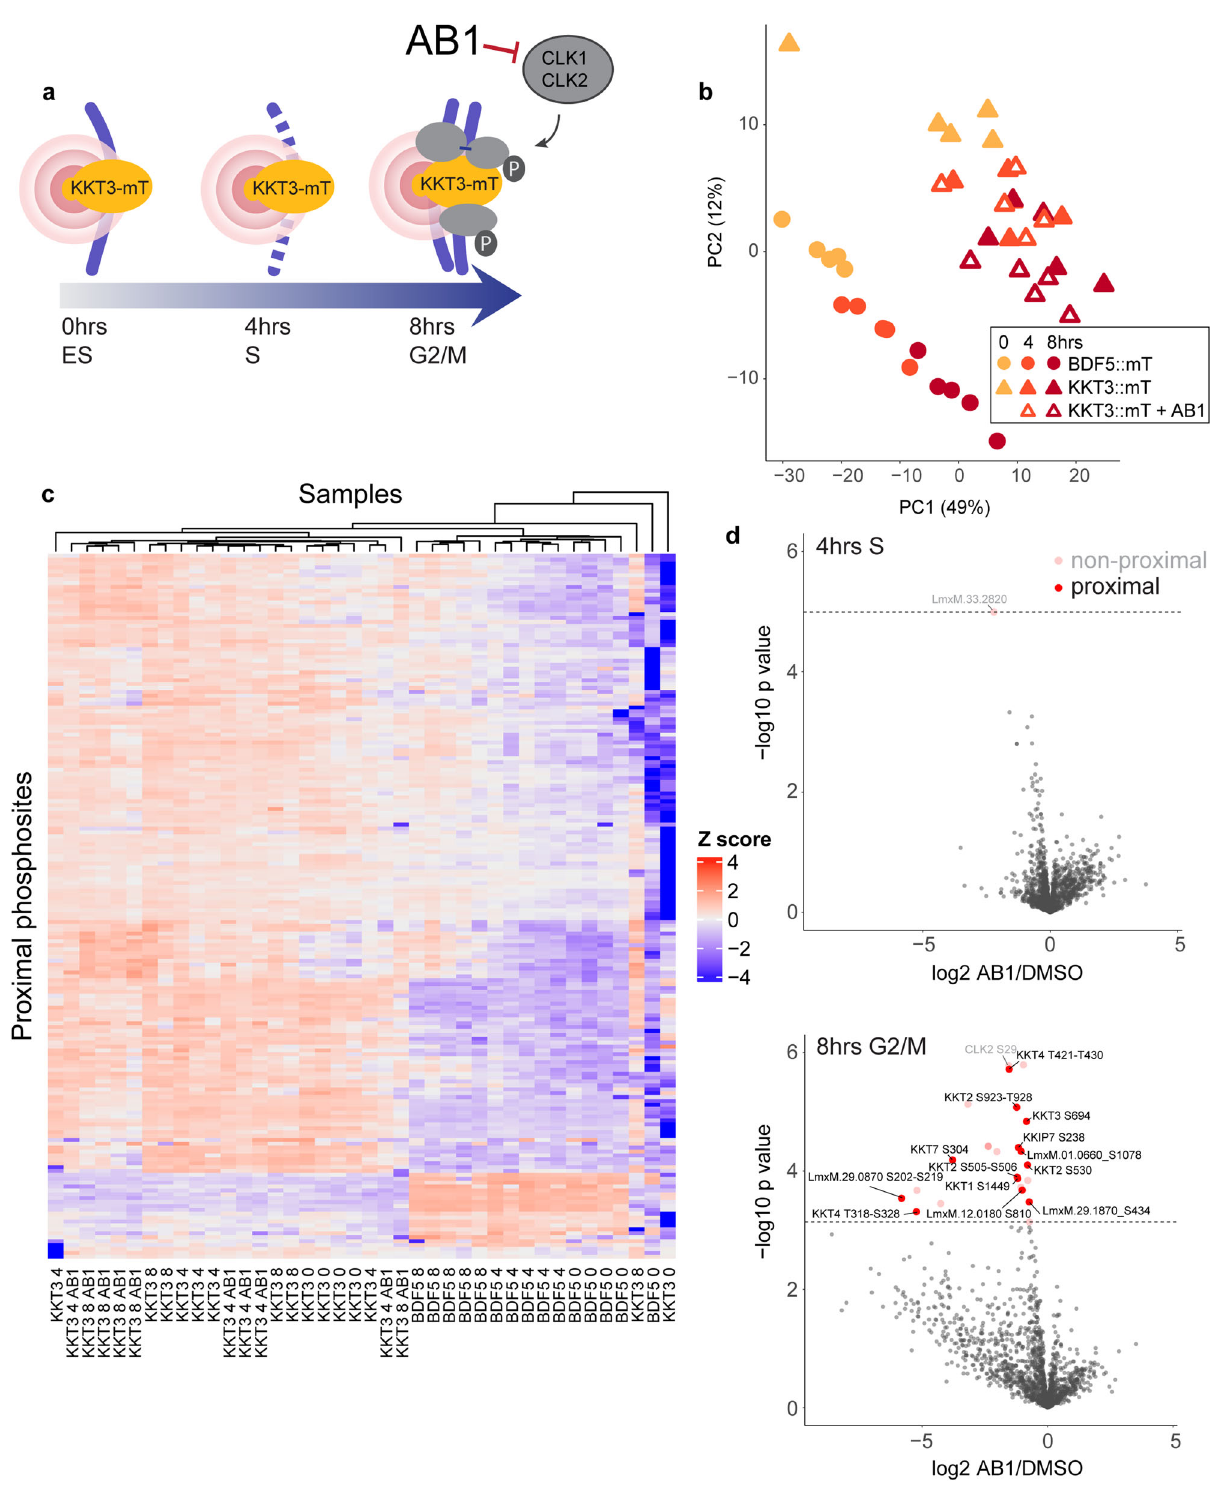
Fig. 5 Kinetochore proximal phosphosites reduced after AB1 inhibition of the kinetochore kinases CLK1/CLK2. a Spatially referenced proximity phosphoproteomics was used as in Fig. 2 but with AB1 treatment from 0 h after synchronisation release. b Principal component analysis (PCA) of phosphopeptides quanti fi ed by spatially referenced proximity phosphoproteomics. PCA was performed on label-free quanti fi ed phosphopeptides with an ANOVA q value <0.1. c Heatmap of 191 proximal phosphosites. Each row is a phosphosite proximal to KKT3 or the spatial reference BDF5 in at least one timepoint at 5% FDR. Phosphosites are clustered by label-free abundance similarity across the samples. Samples are also clustered by similarity. d Label- free quanti fi cation of all phosphopeptides identi fi ed in AB1-treated vs. DMSO-treated parasites at 4 h after AB1 treatment and synchronisation release (top) and 8 h (bottom). Signi fi cantly changing phosphosites after AB1 treatment are either non-proximal to KKT3 (pink) or proximal to KKT3 (red). The dashed line indicates 5% FDR, n =